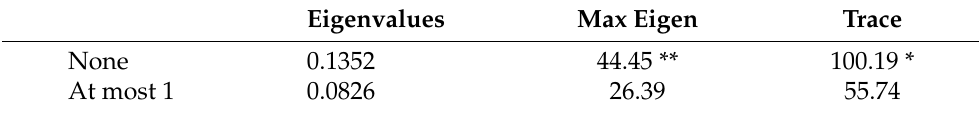
Table 2. Johansen’s Cointegration Tests.